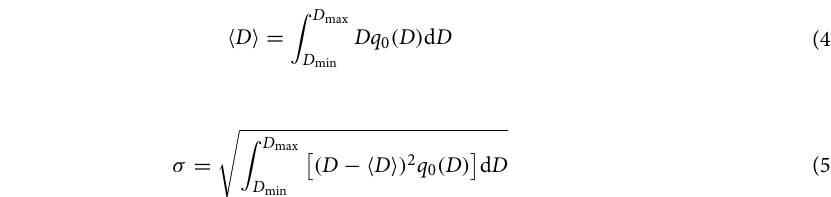
electron beam. Consequently, the size of IONFs determined using HAADF-STEM ( D STEM P